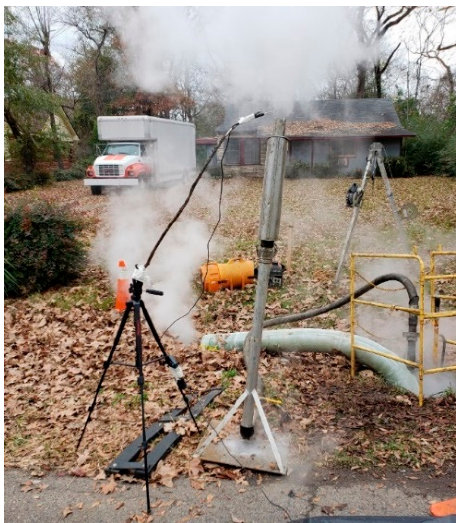
Figure 4. Emissions at Shreveport Site.